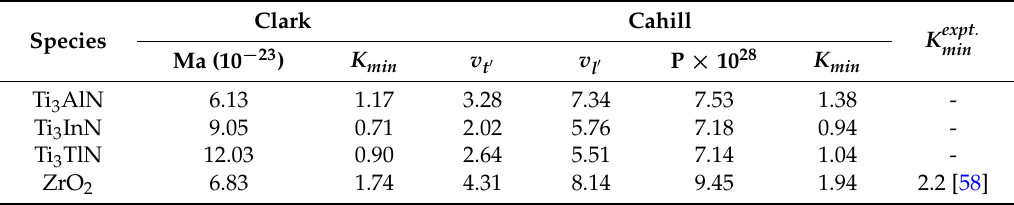
Table 5. Average mass (g) of atoms, transverse acoustic wave and longitudinal wave speed (km · s − 1